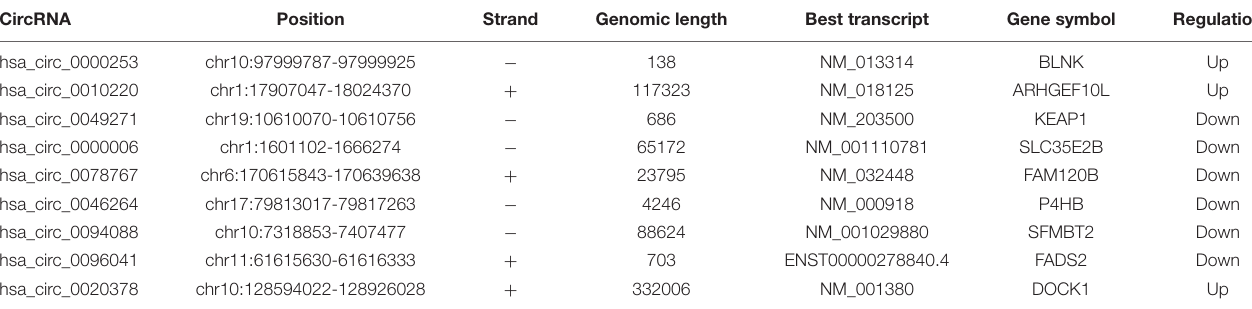
TABLE 2 | Basic characteristics of nine circRNAs. CircRNA Position Strand Genomic length Best transcript Gene symbol